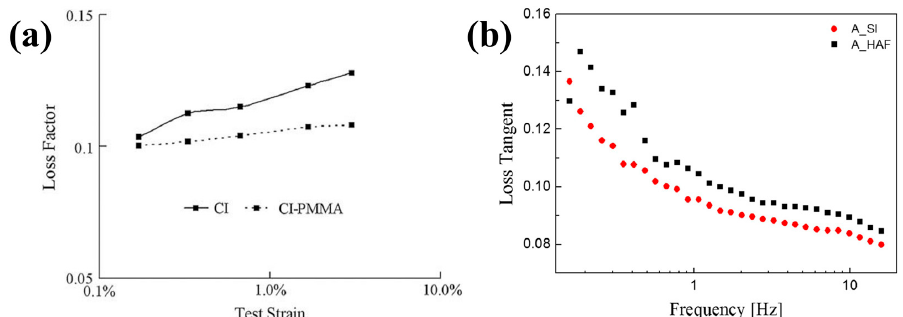
Figure 9. Loss factor of ( a ) CI/PMMA- (dotted) and pure CI- (solid) based MR elastomers (reprinted